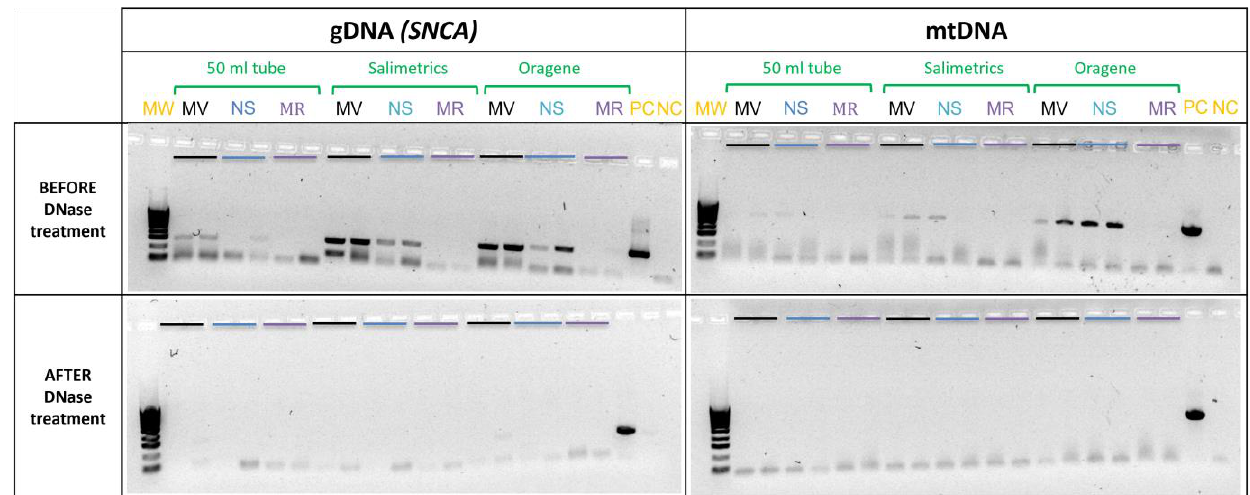
Figure 3. DNA contamination. 1.5% agarose gels showing the purity of the RNA obtained from the different combinations of saliva collectors (50 mL tube, Salimetrics and Oragene) with the miRNA extraction kits (MV, Ambion mirVana miRNA isolation kit; NS, Nucleospin miRNA Plasma kit; MR, miRNeasy Serum/Plasma Advanced kit) before and after DNase treatment. Amplification of an intronic SNP of SNCA gene (280 bp) and a non-coding mitochondrial (mtDNA) region (623 bp) indicates presence of DNA in the nucleic acid extraction. In each reaction, a positive (PC) and a negative control (NC) were included.